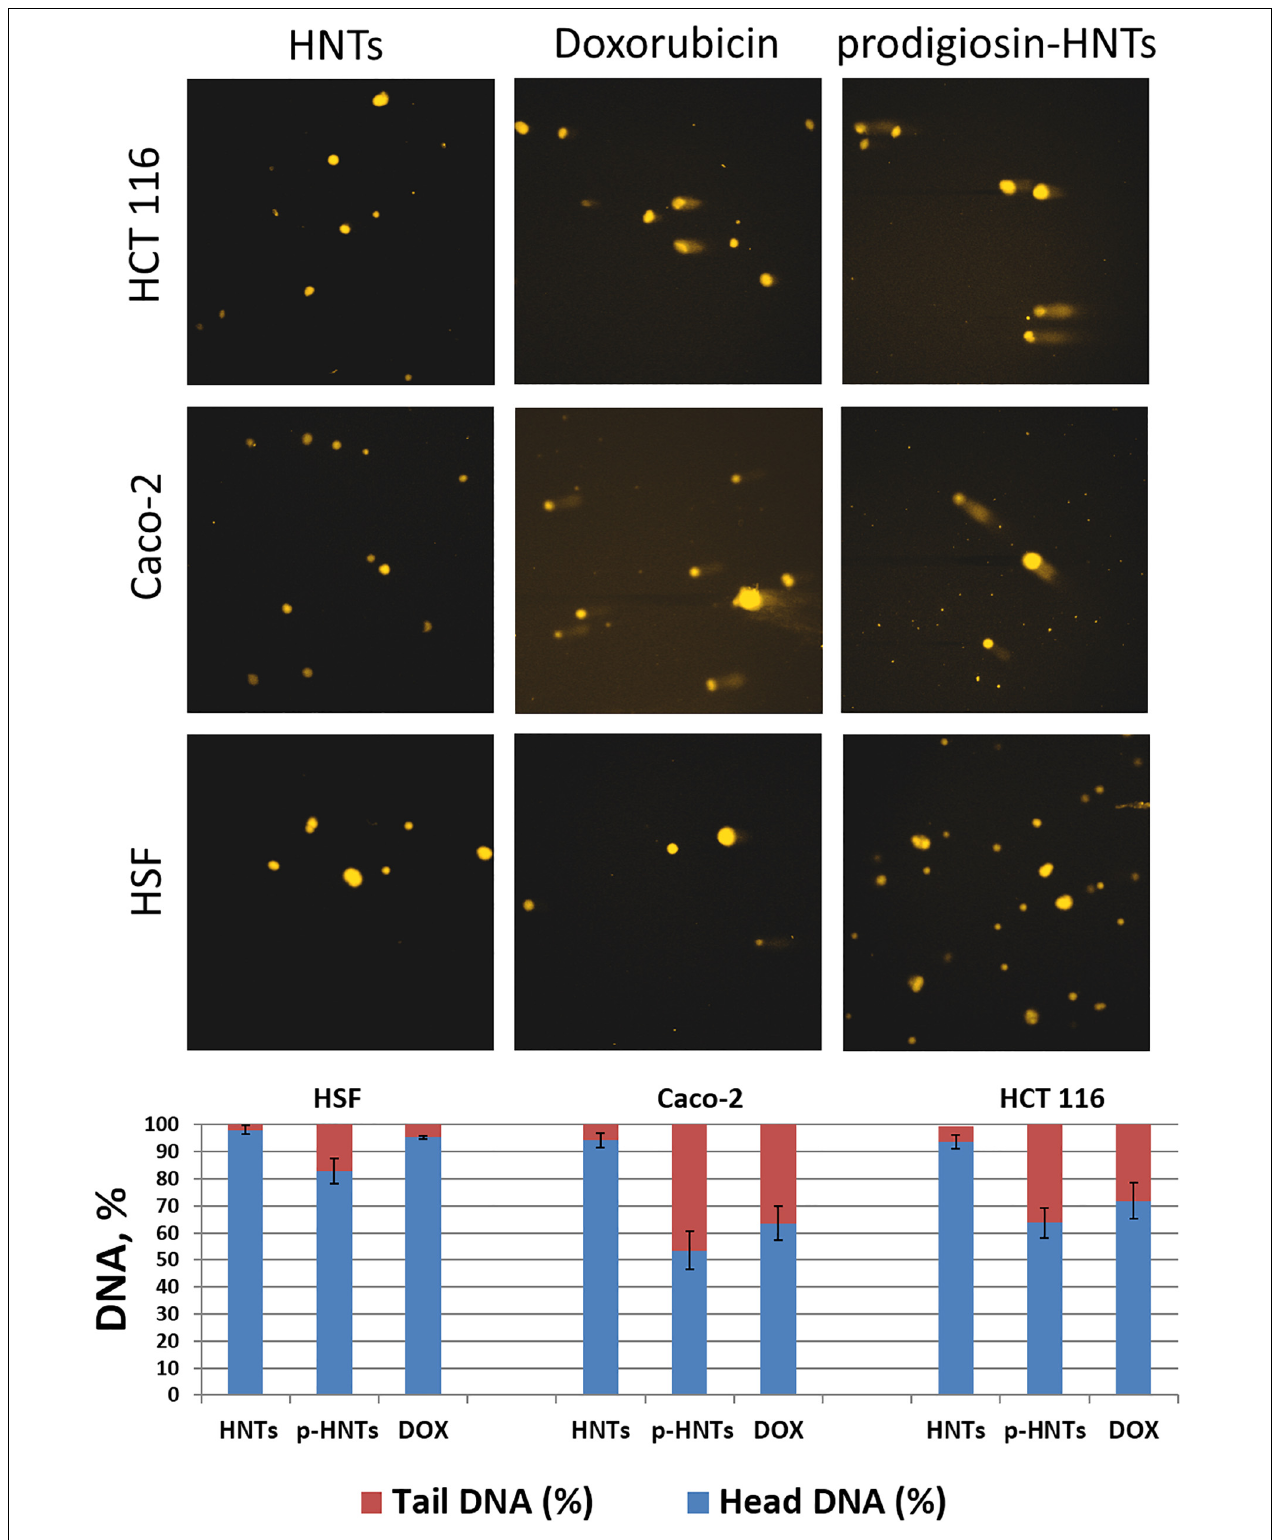
FIGURE 7 | Genotoxic effects of prodigiosin-HNTs (p-HNTs) were evaluated using Comet Assay. Upper image – representative fields of view (fluorescent microscopy) with characteristic undamaged nucleoids and comets in each variant of experiment (specified in figure). The histogram shows the ratio of the DNA percentage in the tail and head of the comets. The semi-automated image analysis system Comet Score was used to evaluate 100 comets per sample.